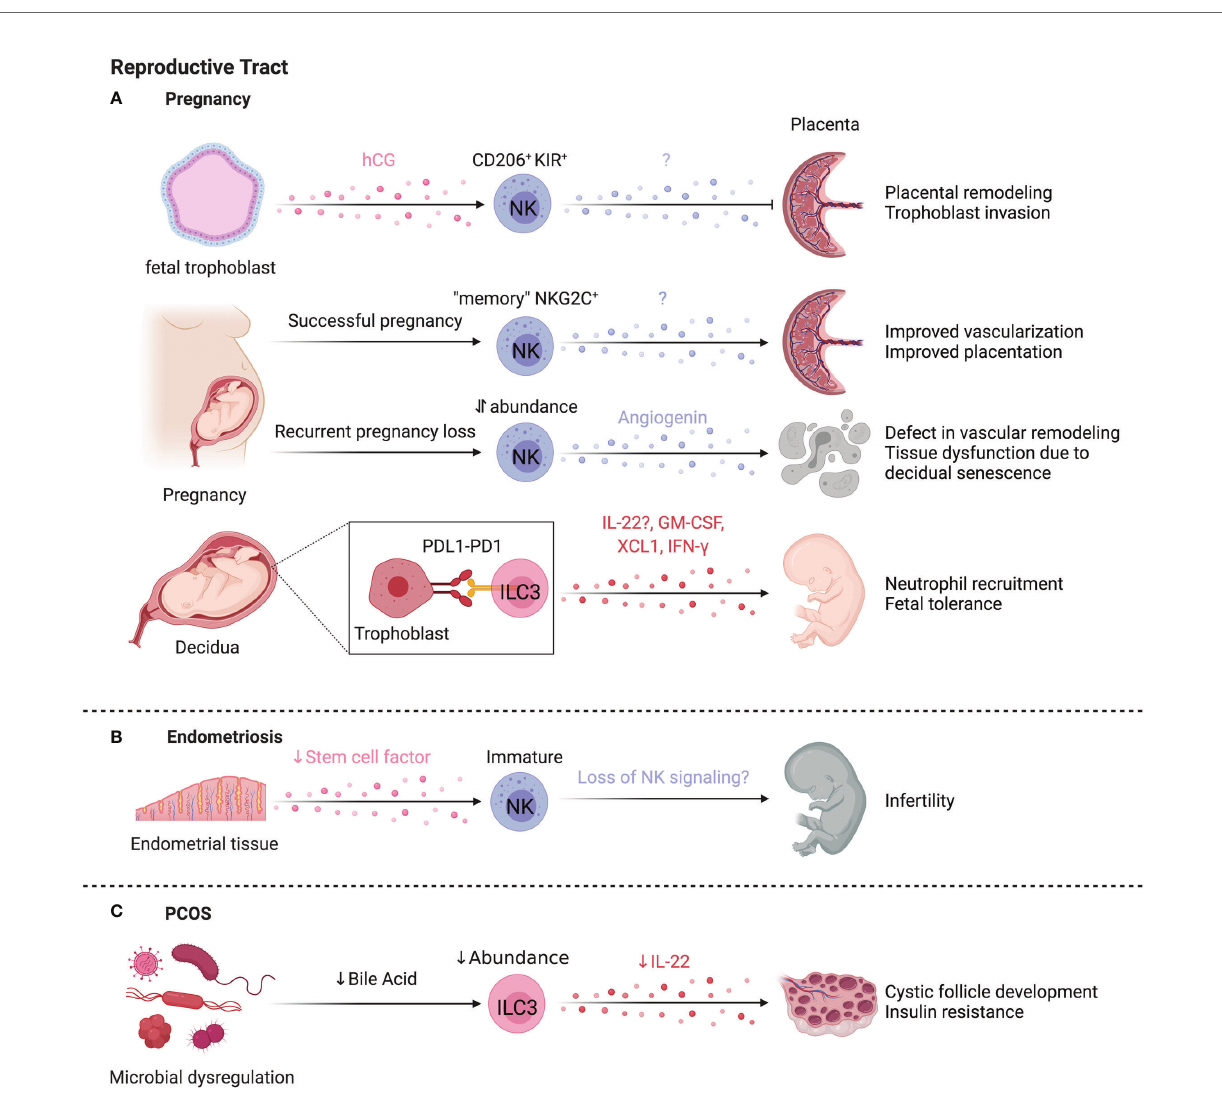
FIGURE 9 | ILCs in the reproductive system. Most ILC data focuses on the female reproductive tract, where NK cells have established roles in pregnancy (A) . uNK cells are regulated by human chorionic gonadotropin (hCG) released by fetal trophoblasts, signaling through CD206 (mannose receptor) to facilitate placental remodeling. Women with recurrent pregnancy losses show an increase in uNK cells in the endometrium, coinciding with thickened spiral artery walls and the resulting vascular remodeling affecting the blood fl ow to the fetus. In support of this, uNK cells from women with recurrent miscarriages also produced more angiogenic factors, fi broblast growth factors, and vascular endothelial growth factors. A special subset of memory uNK cells expressing higher levels of NKG2C contribute to improved reproductive success and lower incidence of pregnancy complications in subsequent pregnancies. In the human decidua, ILC3s express PD-1 and TIM-3, regulating ILC3 cytokine production, in particular IL-33. ILC3-trophoblast interactions may promote fetal tolerance during the fi rst trimester via PD-1: PDL-1 interactions, supported by lower PD-L1 levels in trophoblasts of spontaneous abortions compared to healthy terminated pregnancies. (B) Reduced stem cell factor leads to a higher proportion of immature uNK cells in endometriosis, potentially contributing to infertility associated with endometriosis. (C) In a model of PCOS, microbial dysregulation led to reduced bile acids needed to support ILC3 function. The reduced ILC3 abundance and IL-22 production led to cystic follicle development and insulin resistance. Created with